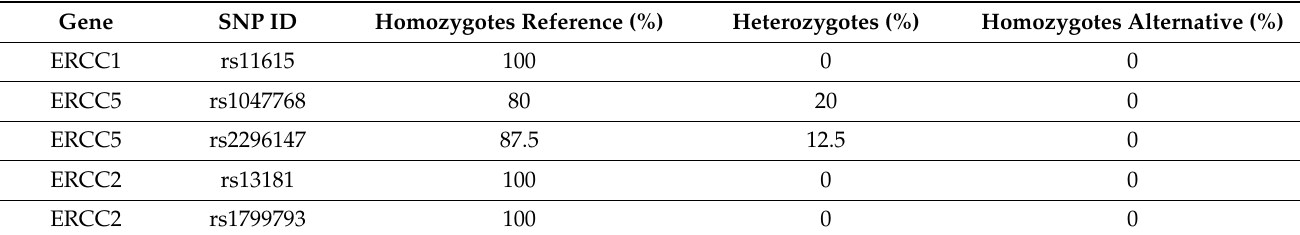
Table 4. Genotypic frequency of SNPs in the somatic line.